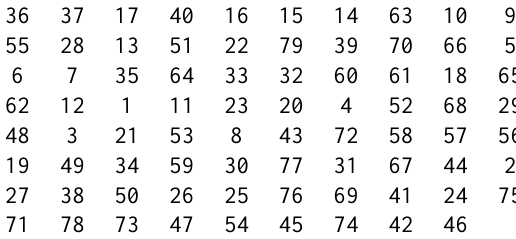
Tab. 1: Order of the genes in D. repleta compared to their order in D. melanogaster segments in the two